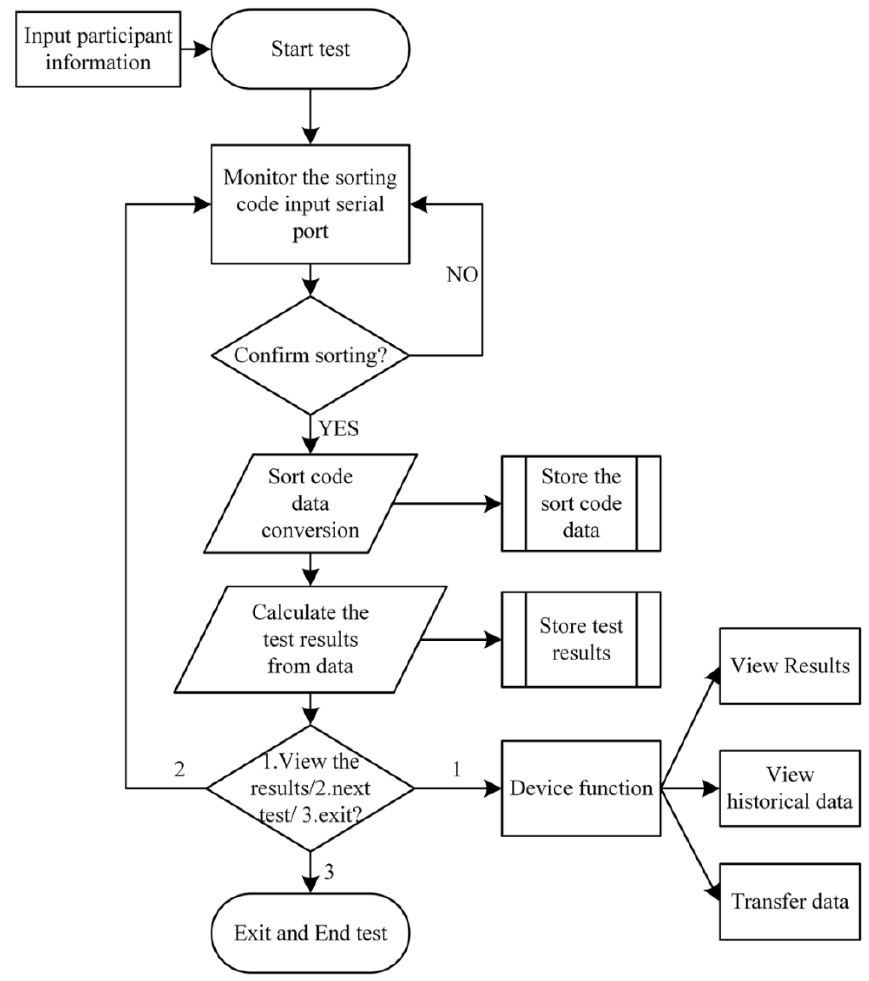
Figure 9. The flowchart of the software design.